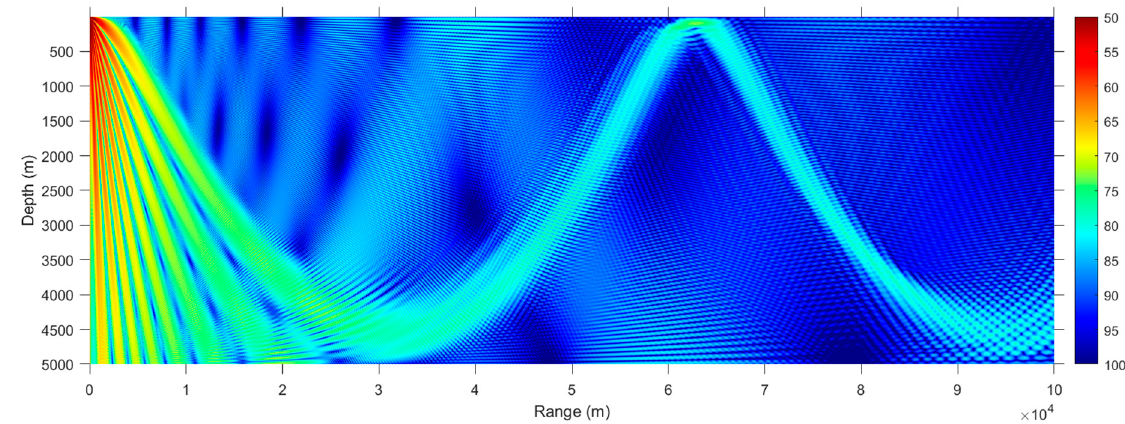
Figure 11. The TL contour in the Munk waveguide case using the SFD with PPW = 20.